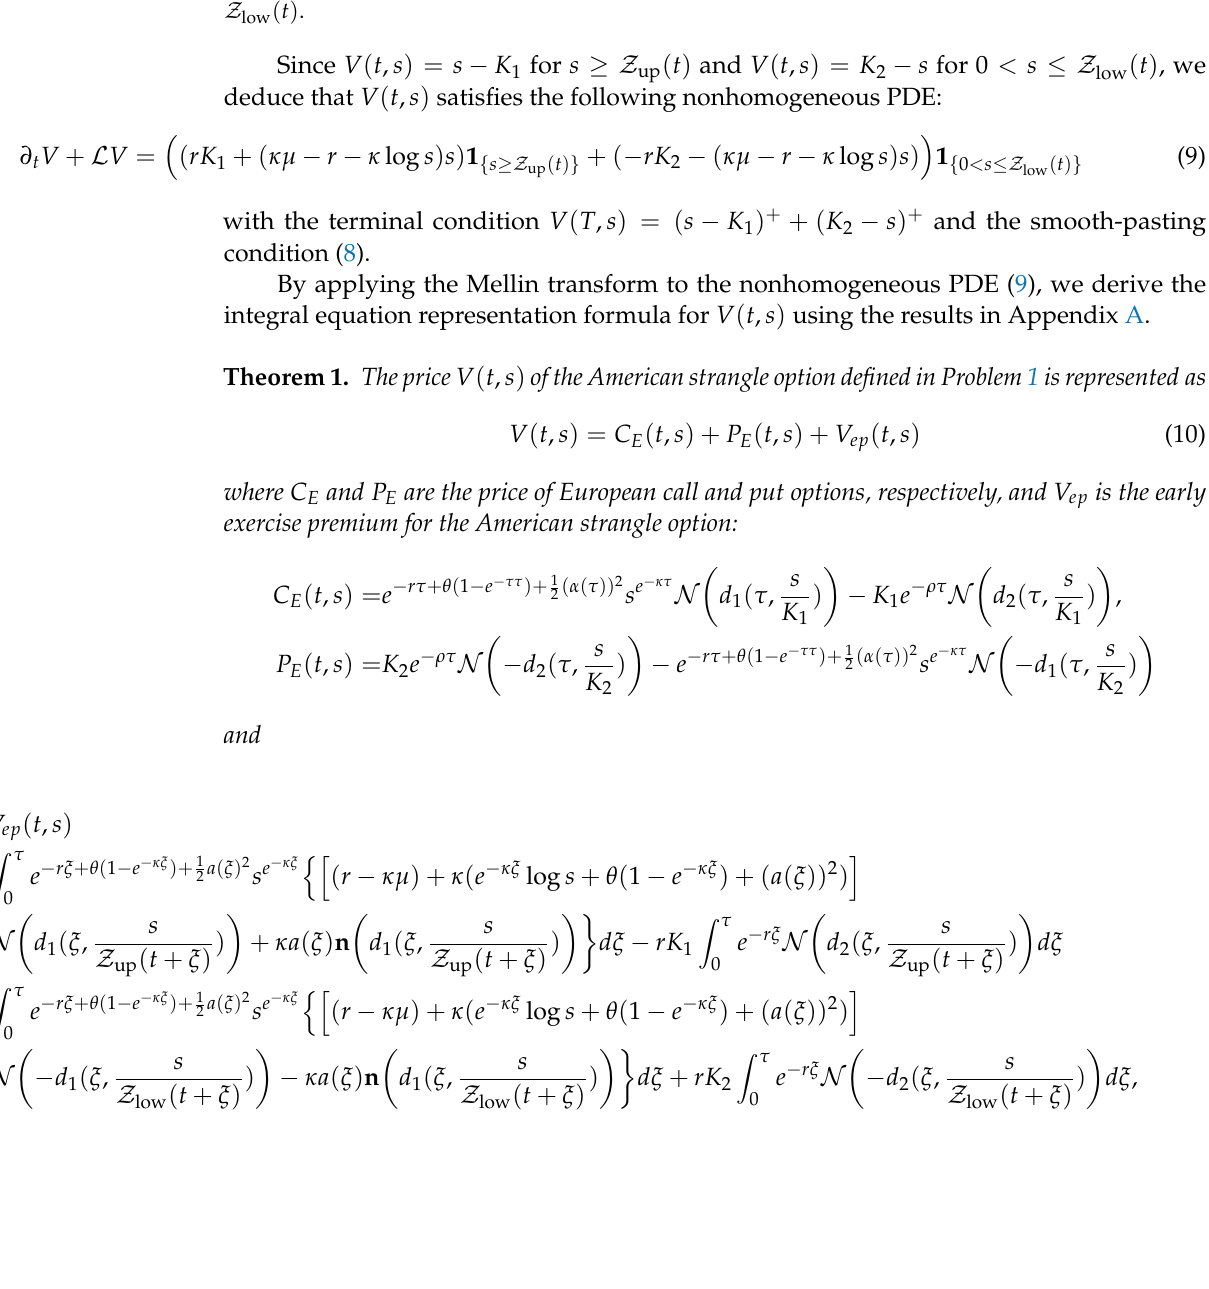
Figure 1. The waiting region WR , the stopping region SR , the two free boundaries Z up ( t ) , and Z ( t ) low